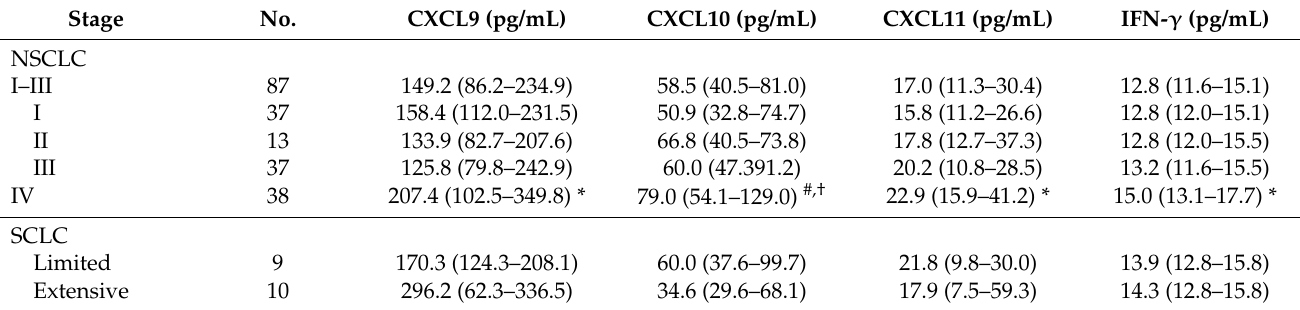
Table 2. Comparison of IFN- γ -inducible chemokines and IFN- γ , depending on the stage in NSCLC and SCLC. Stage